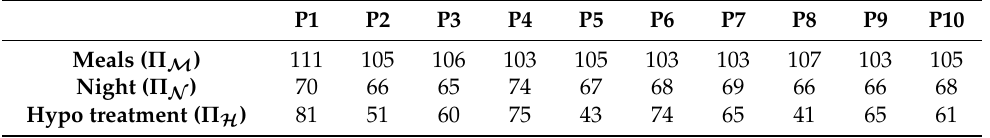
Table 2. Seasonality (in number of samples) resulting from time subseries concatenation in a